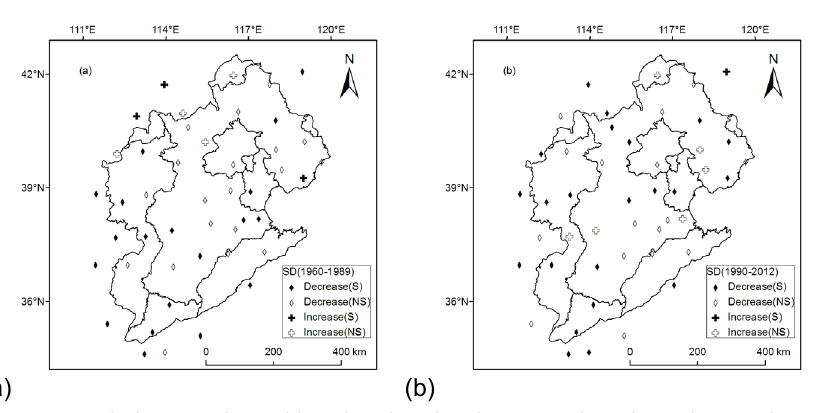
Fig. 4 Trends in annual sunshine duration for the 45 stations in and around Hai River basin during (a) 1960 to 1989, and (b) 1990 to